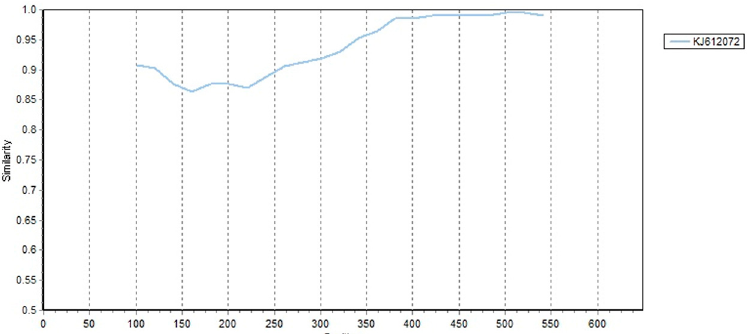
Figure 3. Similarity plot analysis was conducted via Simplot v3.5.1 using a sliding window of 200 nucleotides moving in steps of 20 nucleotides. The genome of strain OL581722 serves as a query sequence. The recombination event is suggested in KJ612072.